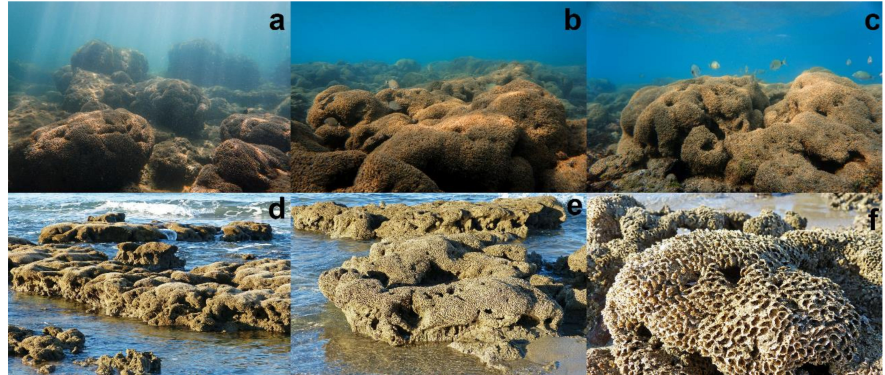
Figure 2. Sabellaria alveolata reef at Tor Caldara, Tyrrhenian Latium coast, Italy, in the upper infralittoral ( a – c ) and emerging during low tide ( d , e ); detail of the peculiar honeycomb-like bioconstruction, showing the tube openings with the “sand crown” as a diagnostic character ( f ). Photo credit: A. Bonifazi and D.